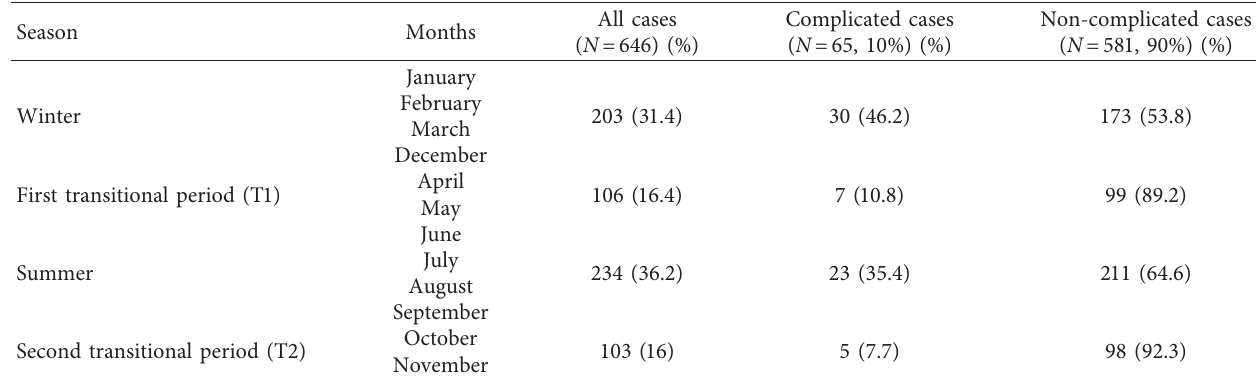
Table 3: Distribution of cases by